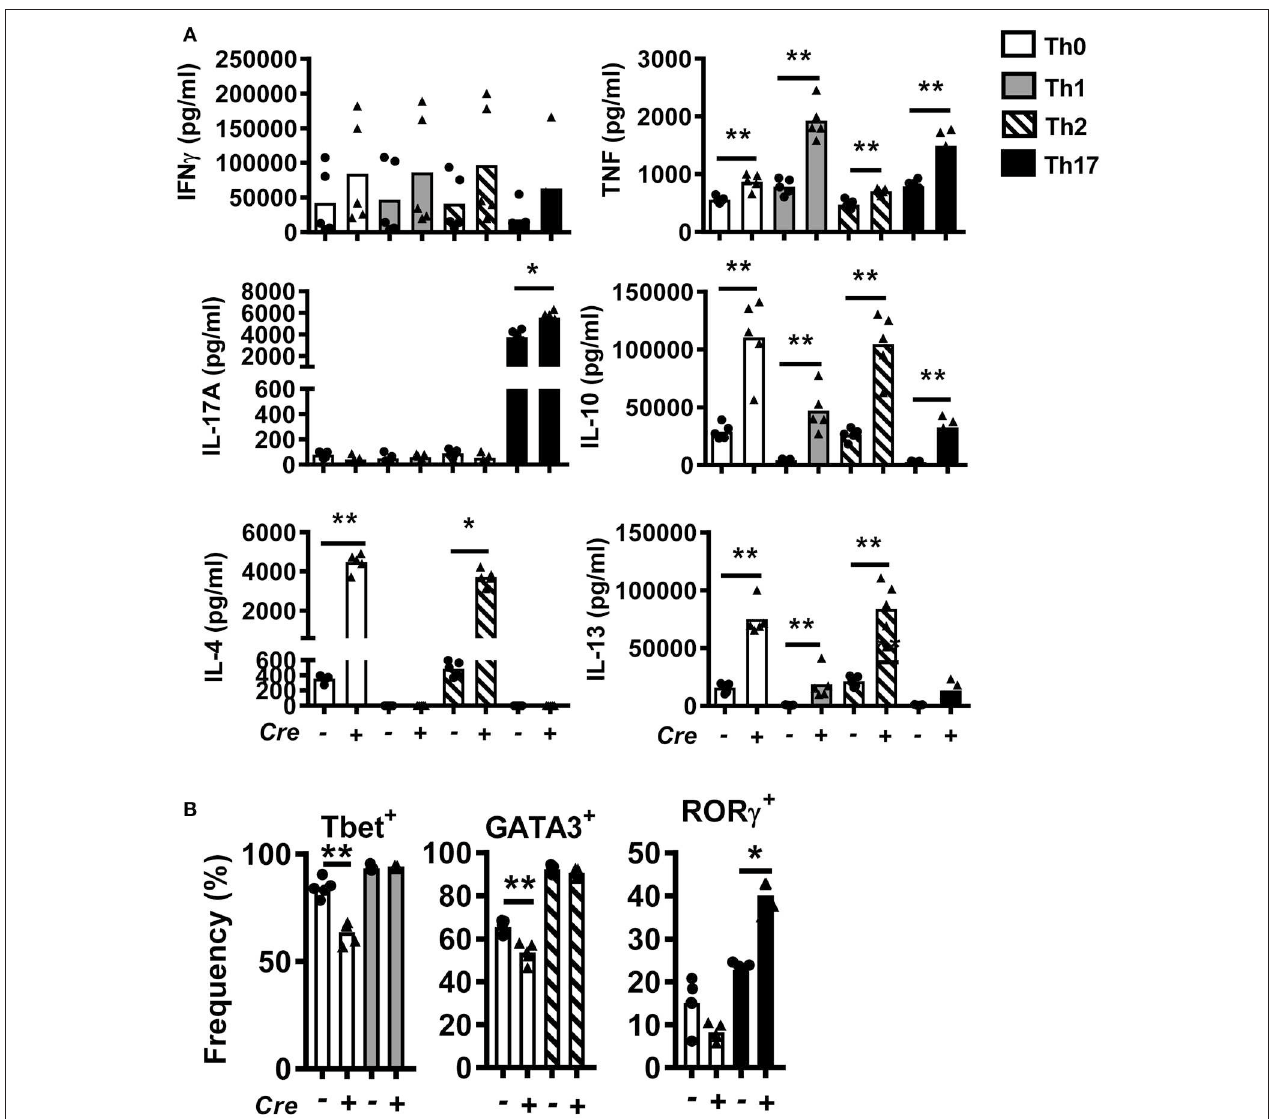
FIGURE 1 | Bach2 inhibits Th17 cell development in vitro . CD4 + T cells were purified from B6. Bach2 ∆ T (closed triangles) or B6. Bach2 fl / fl (closed dots) spleens, as indicated, and cultured with α CD28 and α CD3 mAbs for 5 days under either Th0, Th1, Th2, or Th17 cell polarizing conditions. (A) Cytokine levels in cell culture supernatants were measured and (B) frequencies of CD4 + T cells expressing lineage transcription factors under the various CD4 + T cell polarizing conditions were also assessed. n = 5 mice per condition in duplicate, * P < 0.05, ** P < 0.01, significance assessed by Mann-Whitney